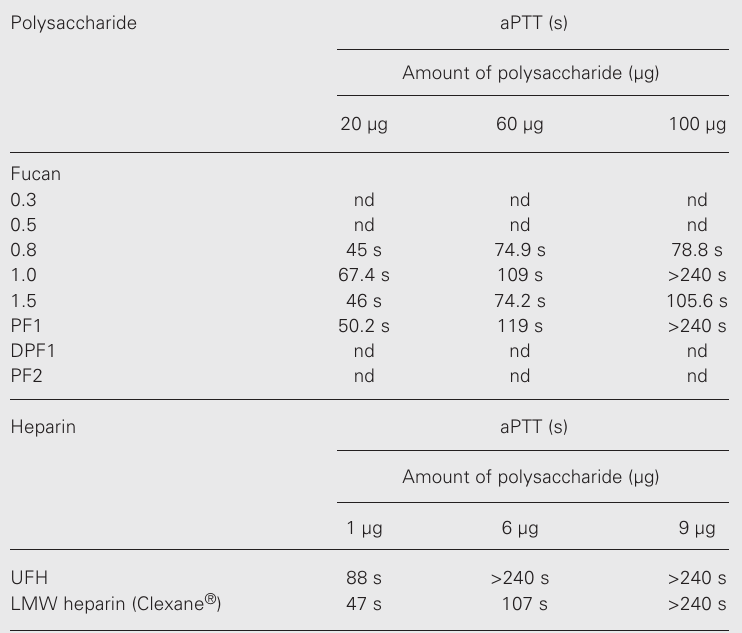
Table 4. Anticoagulant activity of fucans from Padina gymnospora .